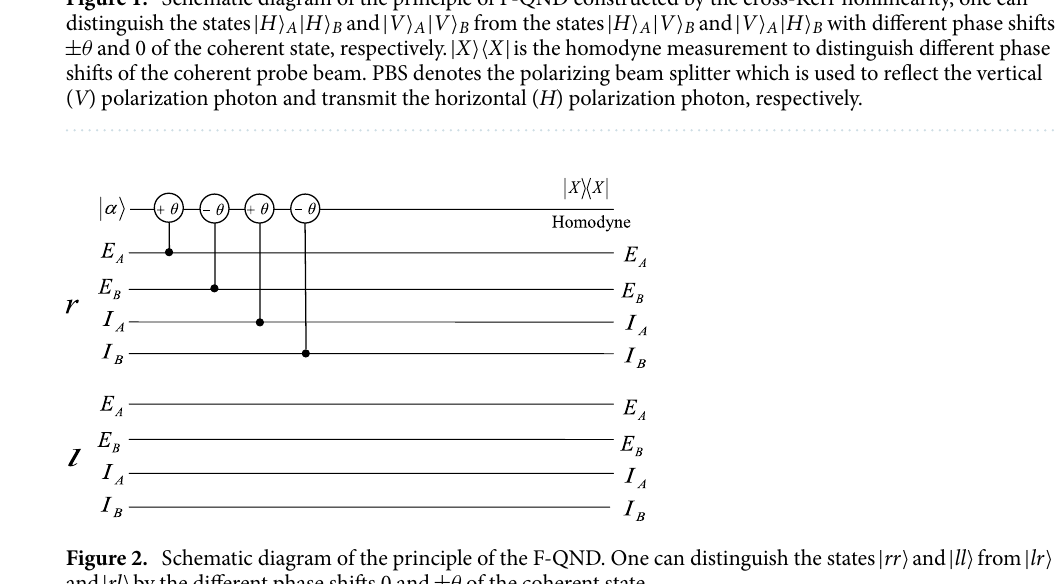
θ of the coherent ±